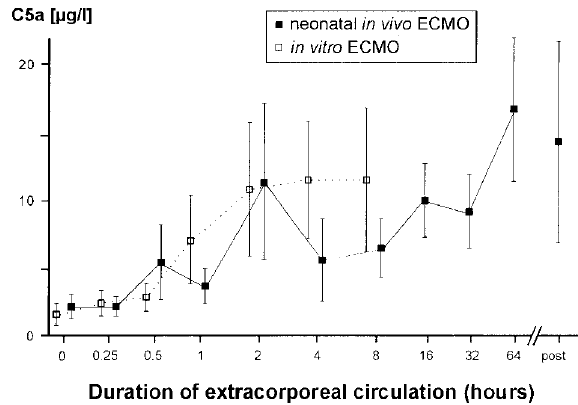
FIG. 2. C5a concentration (mean ± SEM) in in vivo neonatal ECMO and in in vitro ECMO ( n = 6 for both groups). Both groups show significant changes with time during the observation period (Friedman variance analysis) but no difference between both groups. Post, 12h after decanulation.